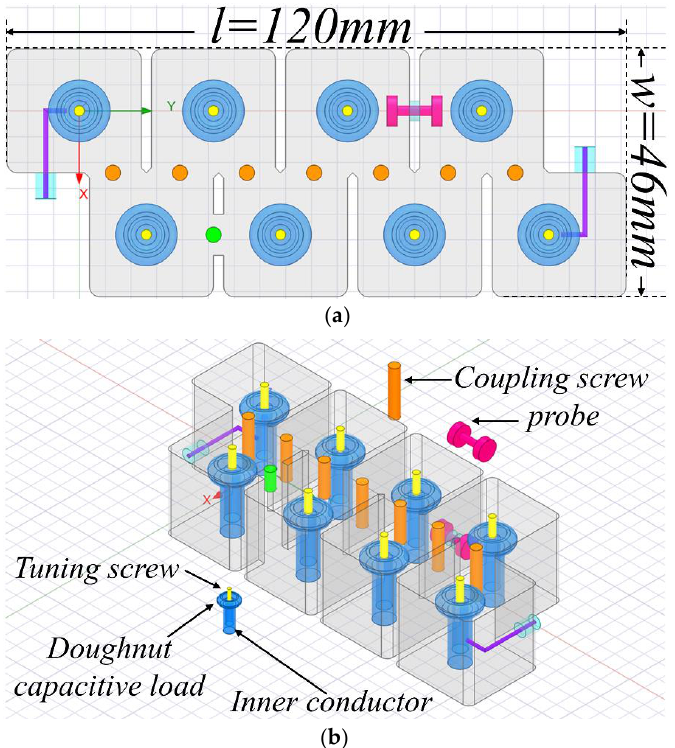
Figure 6. Schematic diagram of ( a ) Cavity filter layout (top) and ( b ) its photograph (3D view). The direct coupling as the primary path is from 1 to 8 in sequence, while the cross- coupling as the auxiliary path is between 2 and 4 and 5 and 7.